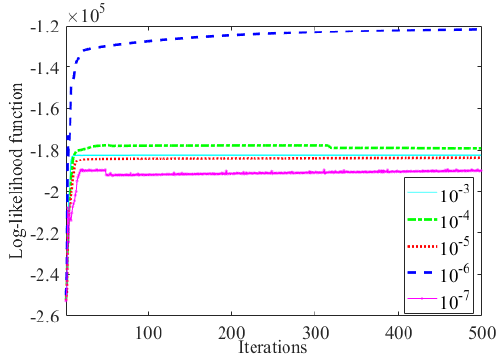
Figure 5. Likelihood function curve with different steps.